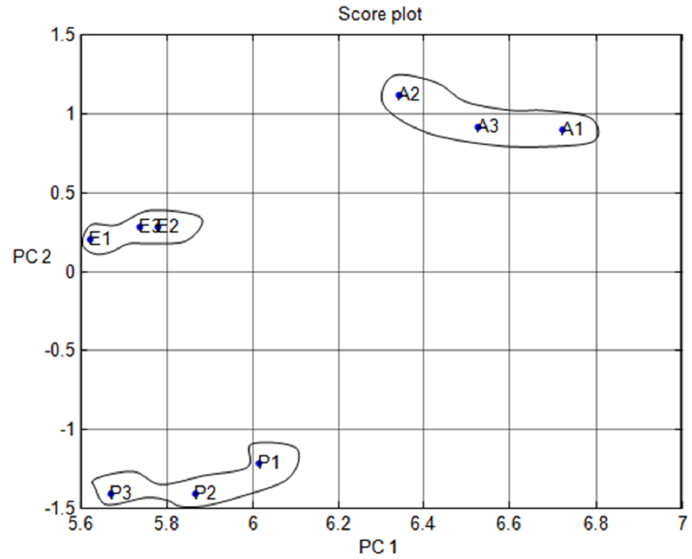
Figure 5. Multivariate technique on organic gases for different feature notch design.